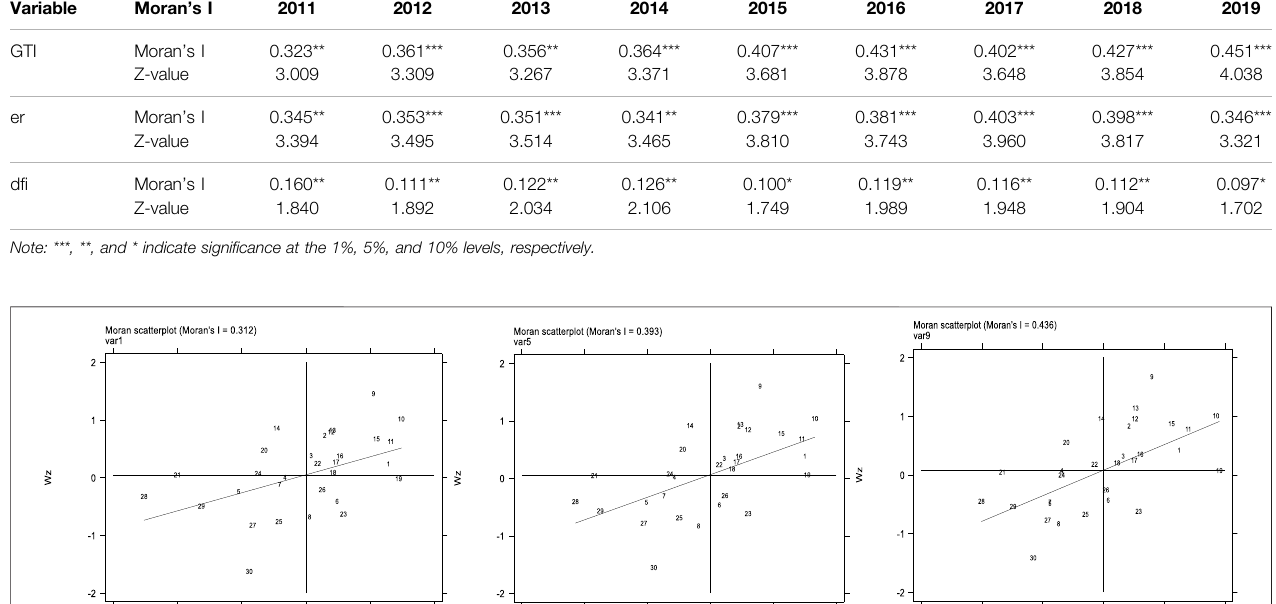
TABLE 2 | Global correlation test: Moran index. Variable